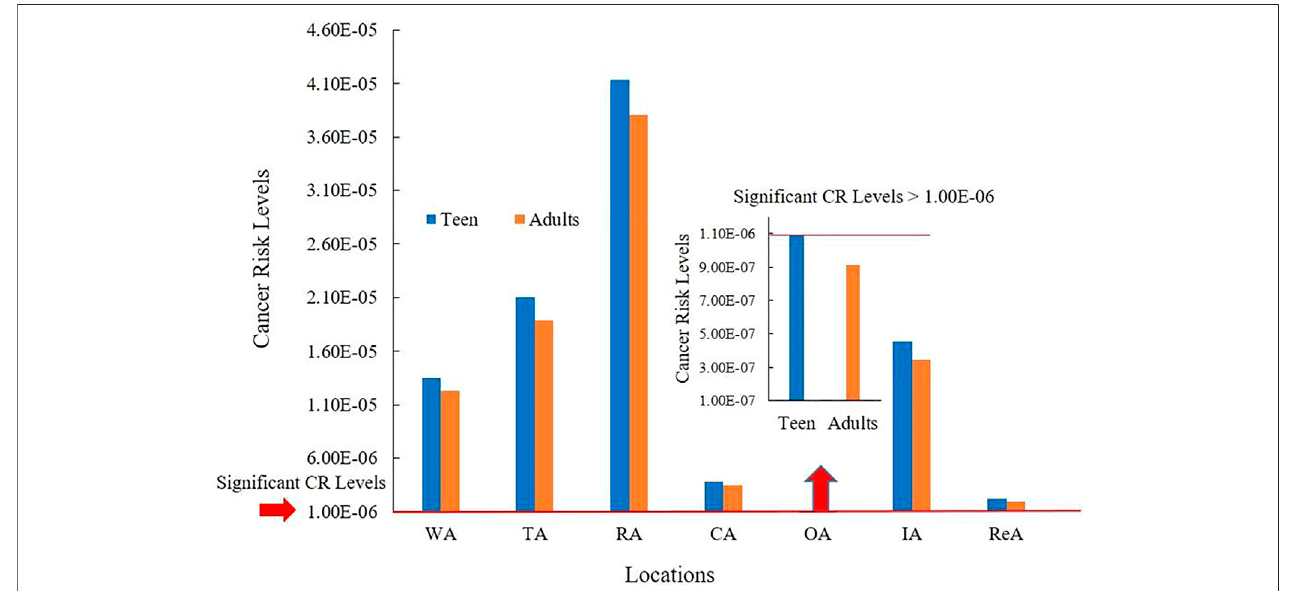
FIGURE 2 | CR levels (95% con fi dence level) at various land-use